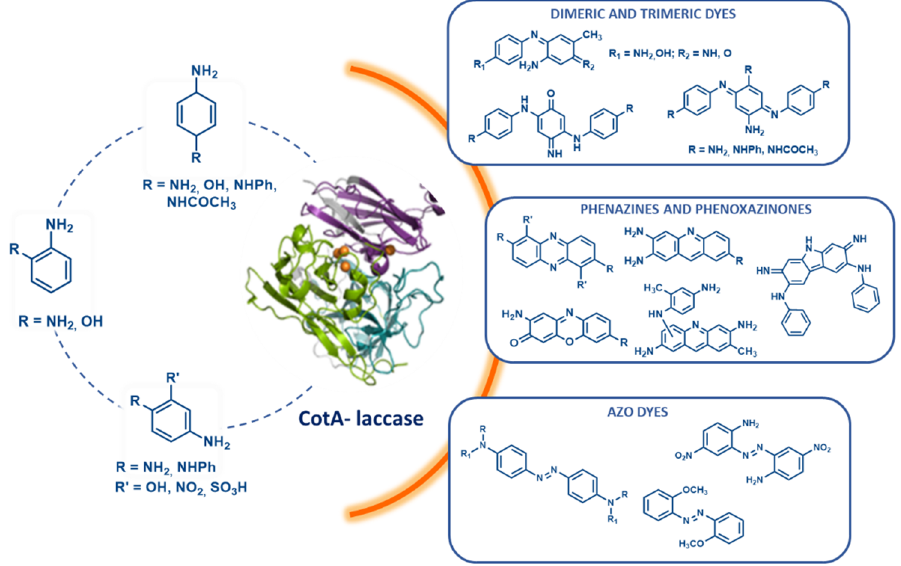
Figure 3. Aromatic scaffolds obtained from oxidation of structurally different aromatic amines using CotA-laccase.